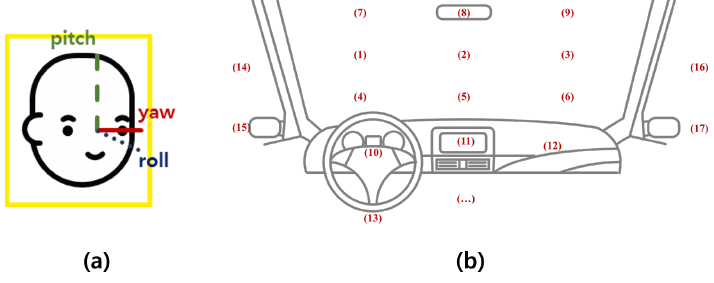
Figure 3. Head direction estimation ( a ) and gaze zone detection ( b ) in the related